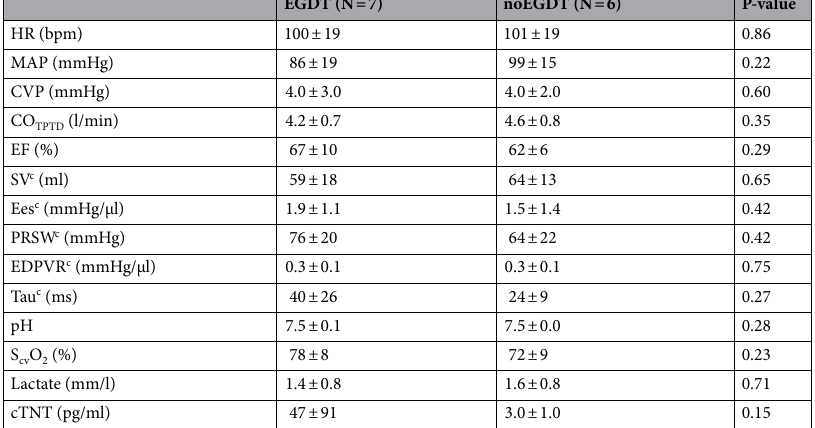
Table 2. Hemodynamic variables and laboratory parameters at baseline. Values are presented as mean ± SD. HR heart rate, MAP mean arterial pressure, CVP central venous pressure, CO TPTD cardiac output derived